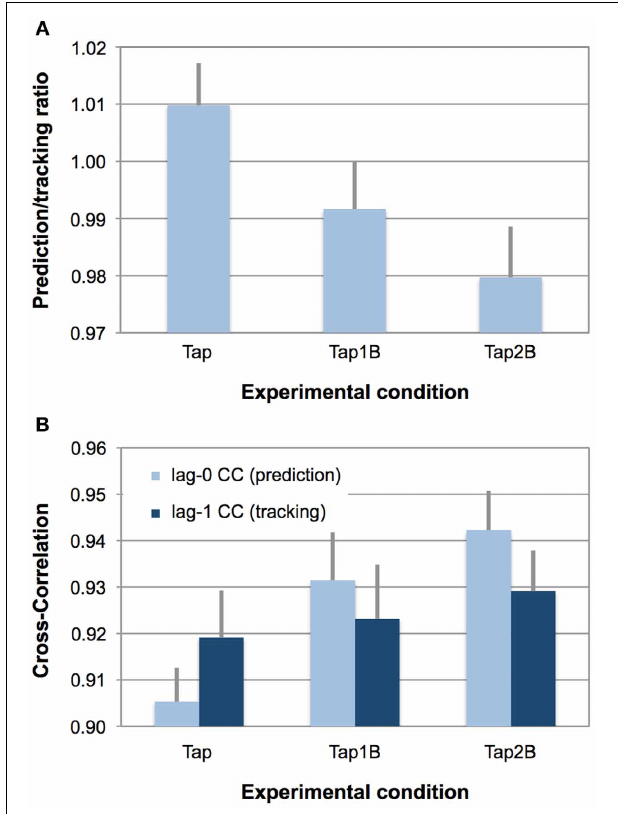
FIGURE 2 | (Panel A) displays observed mean prediction/tracking ratios for the three finger-tapping conditions. Error bars display the standard error of means. Prediction/tracking ratios > 1 indicate relatively stronger temporal prediction than temporal tracking during SMS, prediction/tracking ratios < 1 indicate relatively stronger temporal tracking (i.e., weak prediction). (Panel B) provides an overview over lag-0 and lag-1 CCs separately for the three finger-tapping conditions. Error bars display the standard error of means. Due to the autocorrelation correction, lower indices indicate stronger prediction and